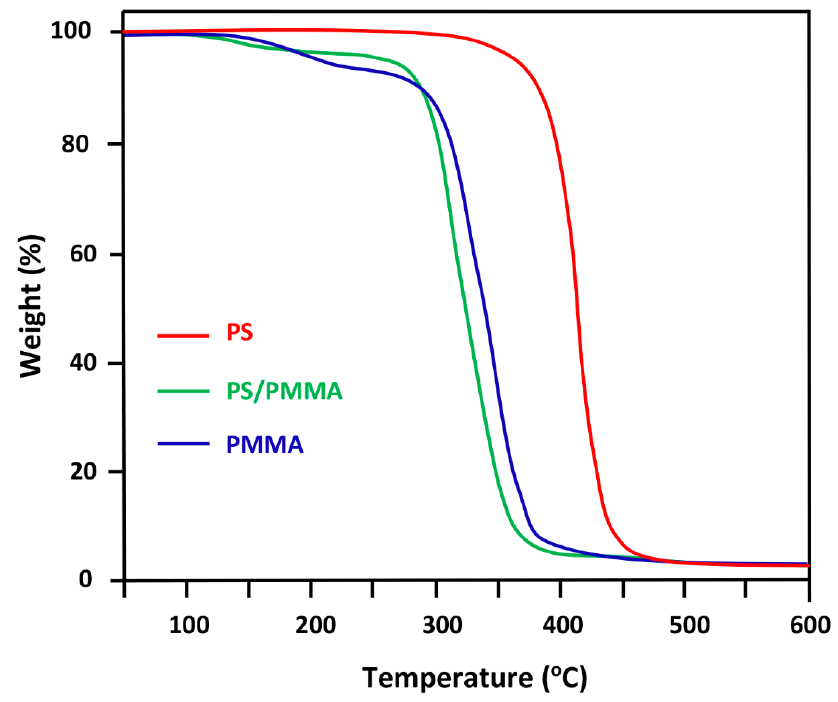
Figure 6. TGA thermograms of pure PS, pure PMMA, and their blend containing 50 wt% of each component.